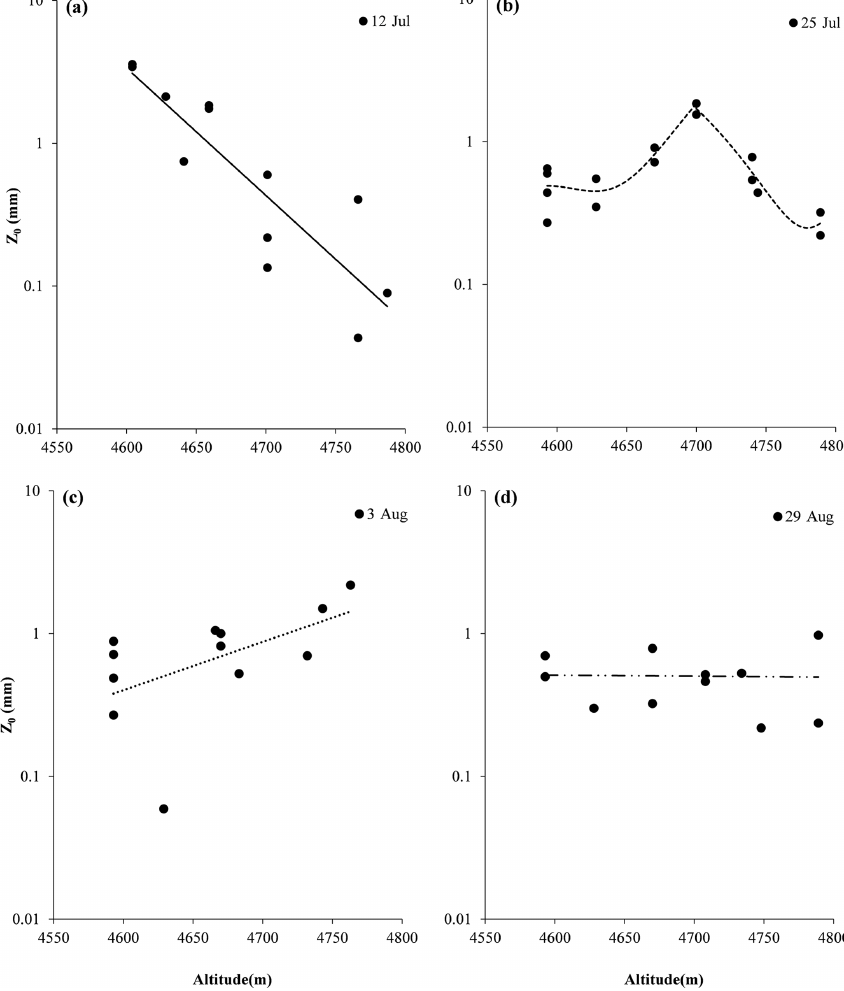
Figure 6. Surface roughness vs. altitude, (a) as observed on 12 July, (b) 25 July, (c) 3 August and (d) 28 August.